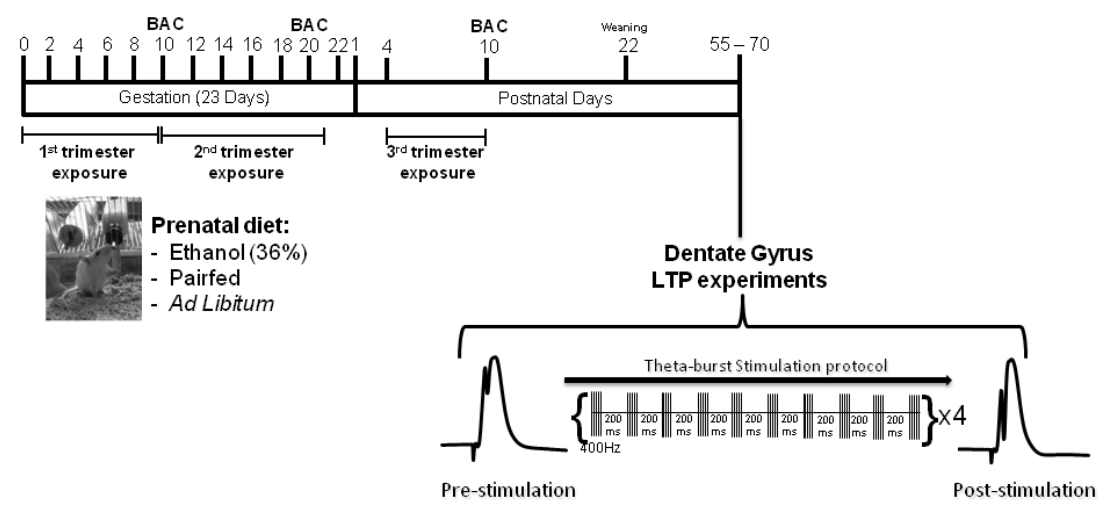
Figure 3. Experimental Timeline. On GD1 pregnant dams were assigned to one of seven treatment groups: Ad libitum controls, 1st trimester equivalent ethanol exposure, 1st trimester equivalent pair-fed, 2nd trimester equivalent ethanol exposure, 2nd trimester equivalent pair-fed, 3rd trimester equivalent ethanol exposure, or 3rd trimester equivalent pair-fed (see text for a detailed explanation of the various groups). Blood samples to assess BAC were taken on GD 10 for the 1st trimester equivalent exposure condition, GD20 for the 2nd trimester equivalent exposure condition, and PND 10 for the 3rd trimester equivalent exposure condition. When animals reached experimental age (PNDs 55–70) they were used for in vivo electrophysiological experiments to examine LTP in the DG of the hippocampus. Basal recordings were first obtained by administering a pulse (0.12 ms in duration) at 0.067 Hz (pre-stimulation). Once a stable baseline was observed for at least 15 min, LTP was induced by applying TBS consisting of 10 bursts of 5 pulses at 400 Hz with an inter-burst interval of 200 ms, which was repeated 4 times at 30 s intervals. The pulse duration was changed to 0.25 ms during TBS. Following TBS, baseline stimulation resumed for 60 min